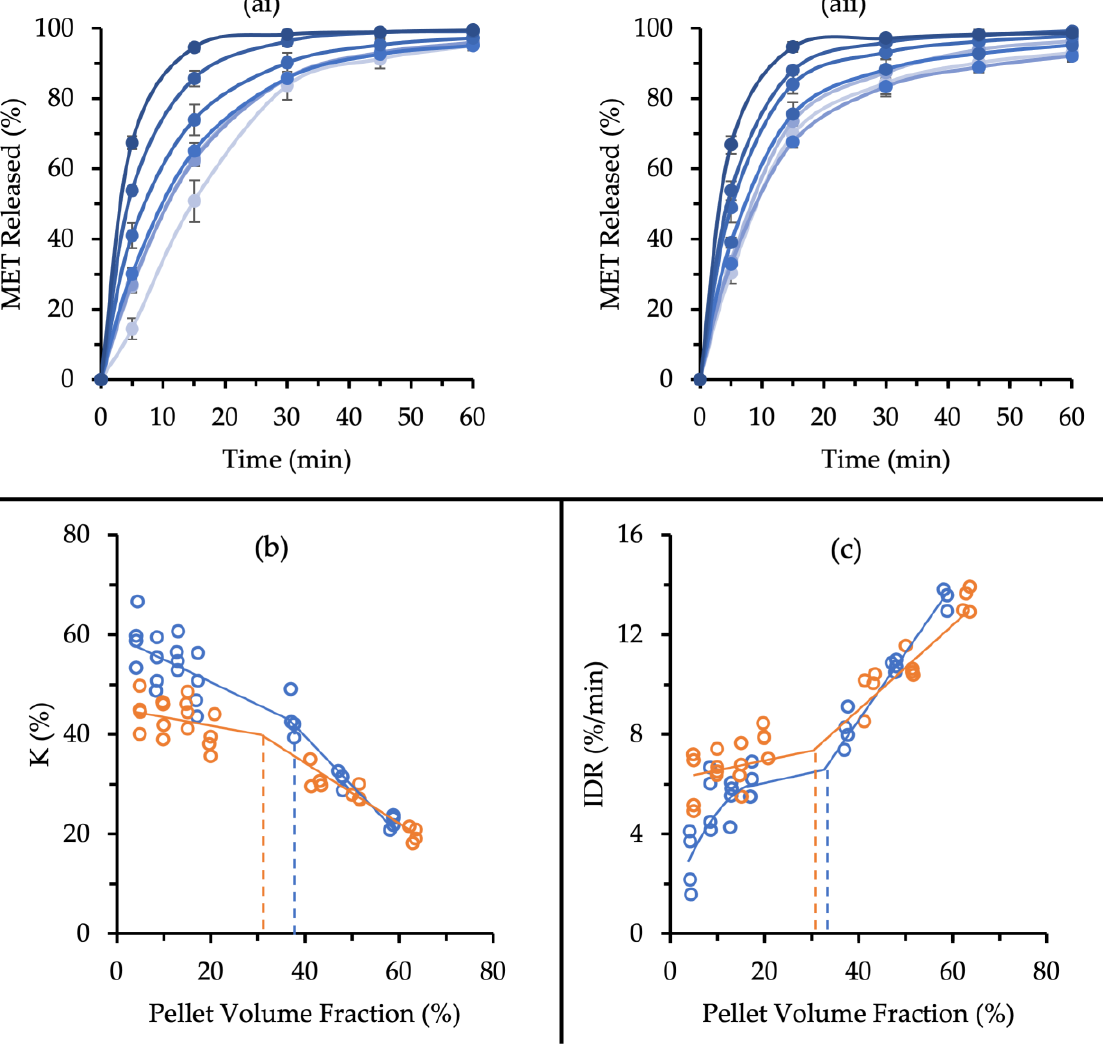
Figure 8. ( a ) MET released over time of ( i ) MCC and ( ii ) XPVP pellets compacted into MUPS tablets at 30 MPa with pellet volume fraction level I ( ), II ( ), III ( ), IV ( ), V ( ), VI ( ), and VII ( ). Error bars represent the standard deviation ( n = 4 ). Plots of ( b ) K and ( c ) IDR values against pellet volume fractions for MCC ( ) and XPVP ( ) pellets. Each symbol represents an individual sample. Approximated trendlines and critical pellet volume fractions are shown for the respective pellets using solid and dashed lines, respectively.